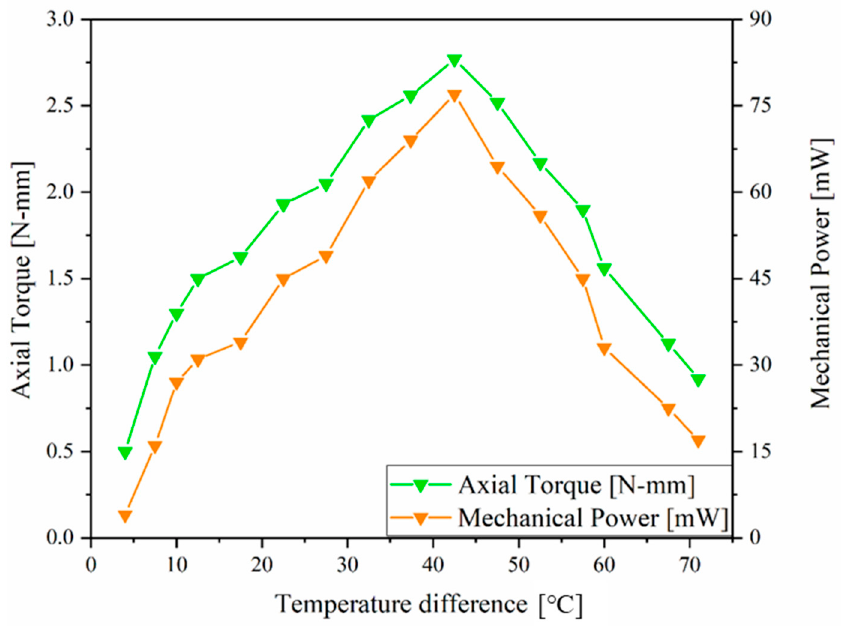
Figure 14. Effect of temperature difference on axial torque and mechanical power of the hybridized EMG/TENG with a vertical configuration.